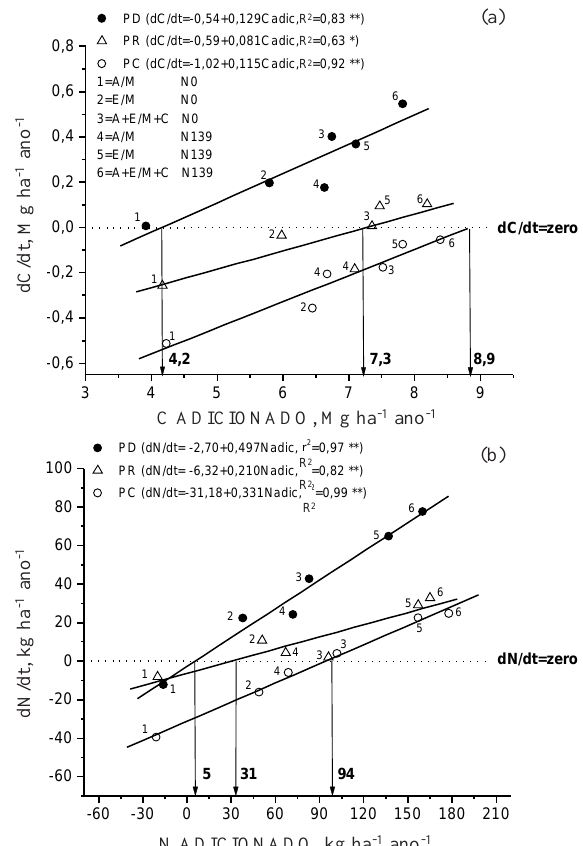
Figura 5. Relação entre as quantidades de carbono (a) e de nitrogênio (b) adicionadas com a variação (dC/dt, dN/t) dos estoques destes elementos na camada de 0-0,175 m do solo submetido aos sistemas de preparo convencional (PC), preparo reduzido (PR) e plantio direto (PD) e três sistemas de culturas, com e sem adição de N mineral. A = aveia, M = milho, E = ervilhaca, C = caupi. * e **: Significativo a 5 e 1 %,